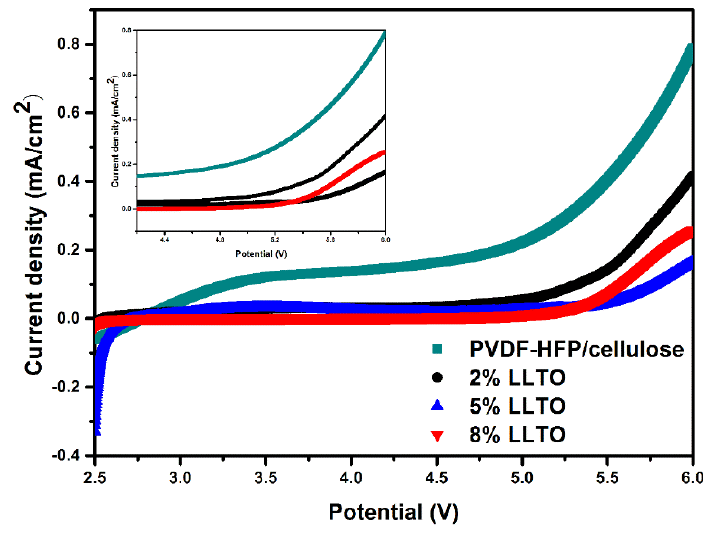
Figure 7. LSV curve of PVDF ‐ HFP/cellulose and LLTO composite separators at a scan rate of 1.0 mV s − 1 .